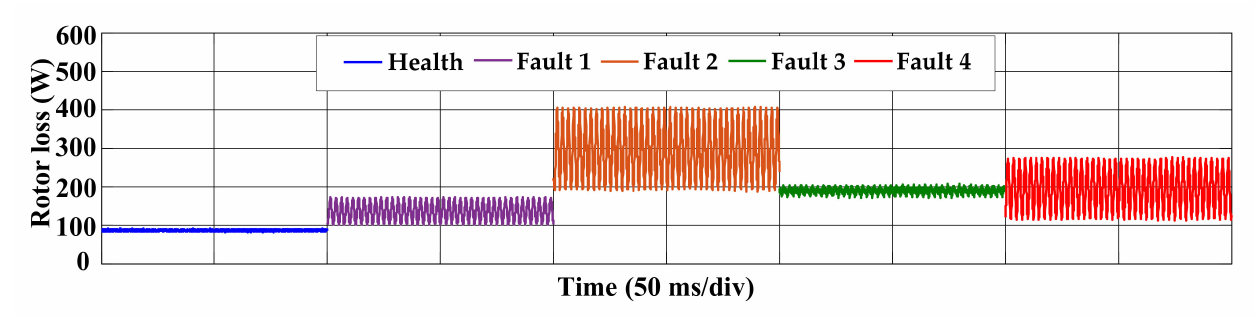
Figure 7. FE results of the rotor Joule loss for health and fault conditions under 20 Nm.